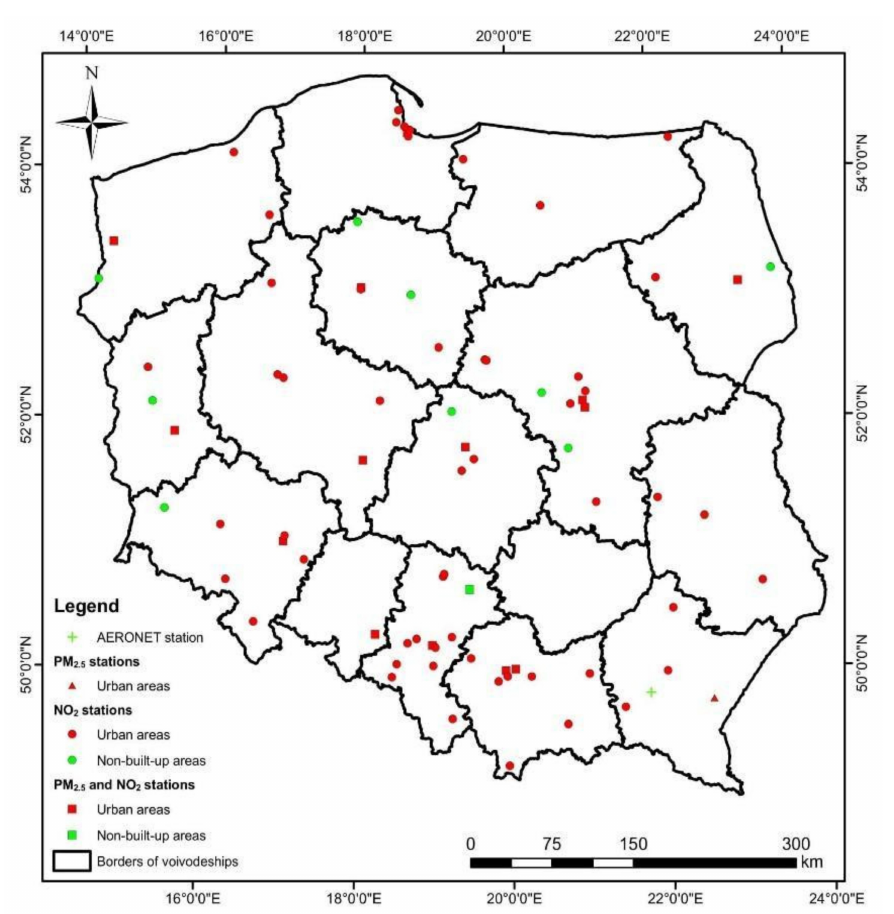
Figure 1. Location of GIOS stations measuring NO 2 , PM 2.5 and the AERONET station. Red squares correspond to urban stations where PM 2.5 and NO 2 are measured, while green squares correspond to non-built-up stations. Red triangles correspond to PM 2.5 urban stations. Red circles to NO 2 urban stations, while green circles are for NO 2 non-built-up stations. A green cross gives the location of the AERONET background station in Strzyzow where aerosol optical properties were